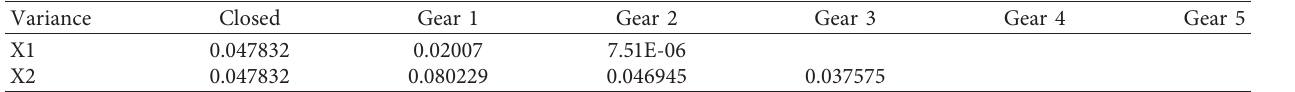
Table 8: Variance of harmonic content rate under each operating